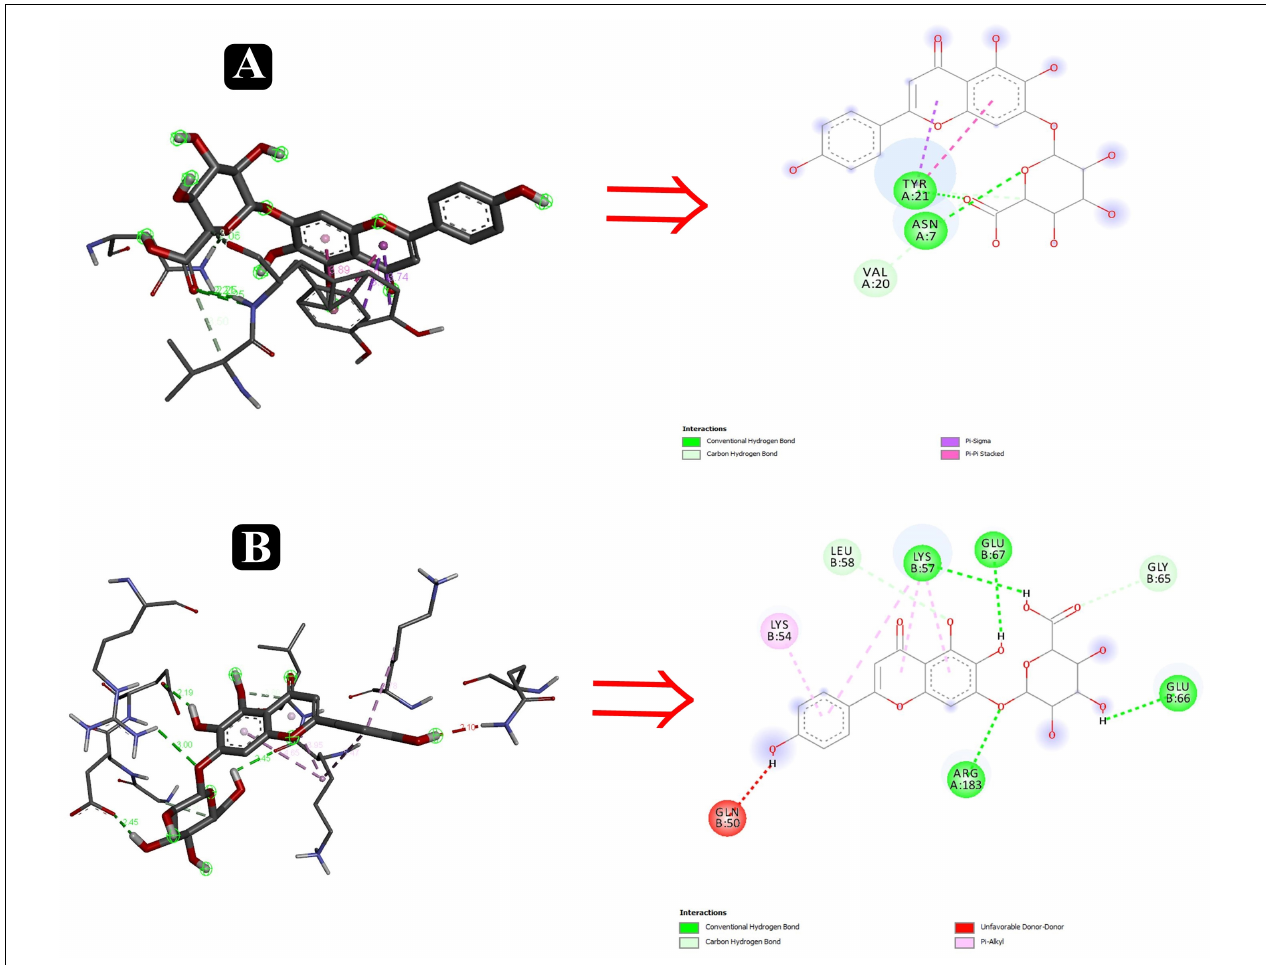
FIGURE 11 | Interactions of adhesin proteins with phytochemicals. (A) 1TR7 from E. coli with higher binding affinity antibiofilm agent scutellarin. Interaction of active site amino acid residue ASN7, VAL20, and TYR21 from 1TR7 with scutellarin; and (B) 1XOU from E. coli with higher binding affinity antibiofilm agent scutellarin. Interaction of active site amino acid residue ARG183, GLN50, GLN66, GLU67, LEU58, and LYS57 from 1XOU with